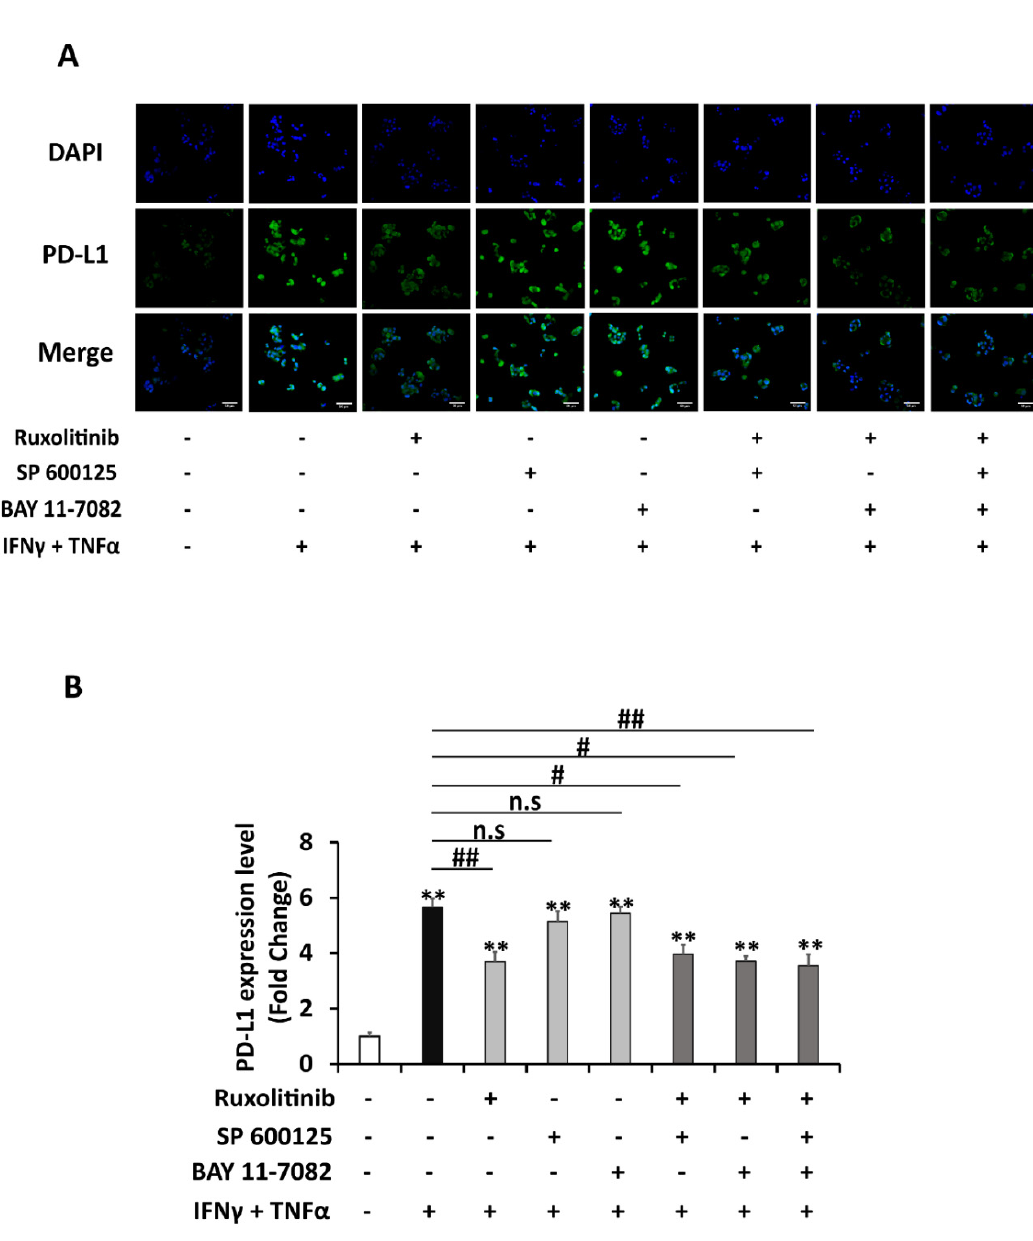
Figure 5. STAT-1 signaling is the major pathway for the upregulation of PD-L1 expression by combination treatment of IFN γ and TNF α . ( A ) Representative figure and ( B ) quantification of immunocytochemistry analysis of PD-L1 membrane expression in HepG2 cells pre-treated for 2 h with individual or combination of inhibitors: JAK inhibitor (ruxolitinib 1 µ M), JNK inhibitor (SP 600125 10 µ M), NF- κ B inhibitor (BAY 11-7082), which was followed by treatment with a combination of IFN γ 1 ng/mL and TNF α 10 ng/mL for 24 h. Scale bar = 50 µ m. Data are presented as mean ± SEM. n = 3. * p < 0.05, ** p < 0.01 compared to control. # p < 0.05, ## p < 0.01 compared to IFN γ and TNF α combined treatment.